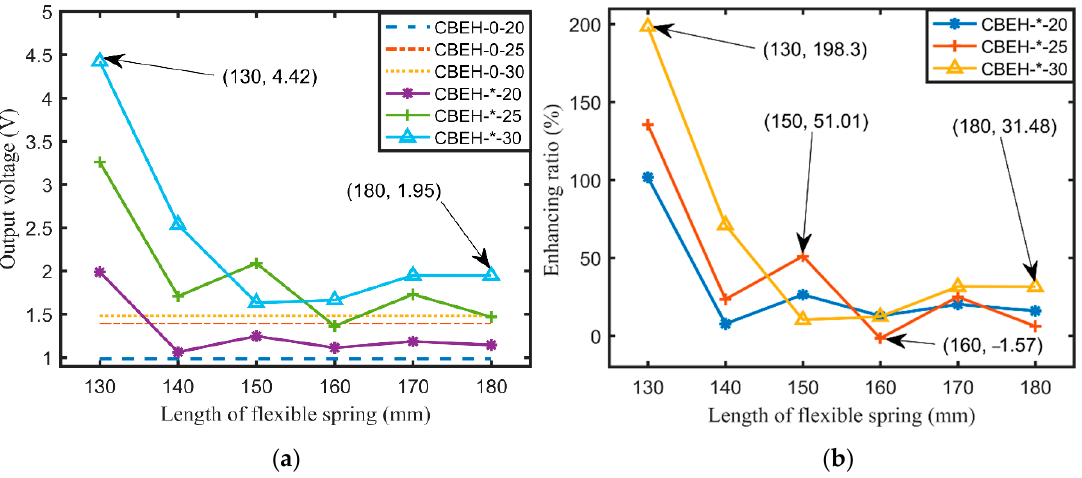
Figure 12. Output voltage and enhancing ratio of CBEH as a function of the length of the flexible spring: ( a ) output voltage; and ( b ) enhancing ratio.